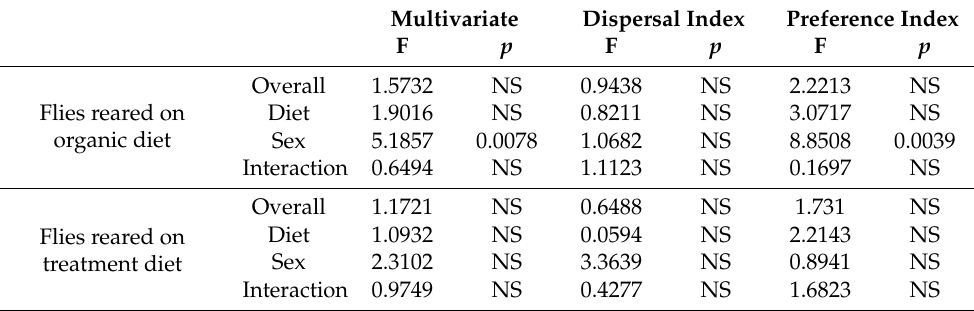
Table 1. Statistical results from Wilks’ λ , multivariate ANOVA, and F-test for Dispersal Index and Preference